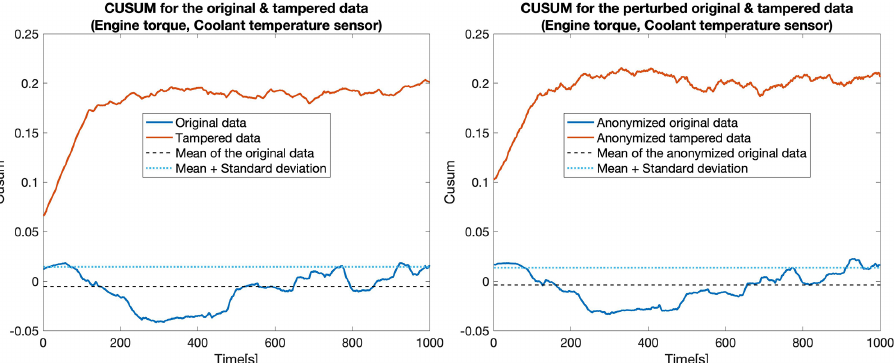
Figure 12. CUSUM for the original data (blue) and tampered data (orange) for sensors: Engine torque and Coolant temperature